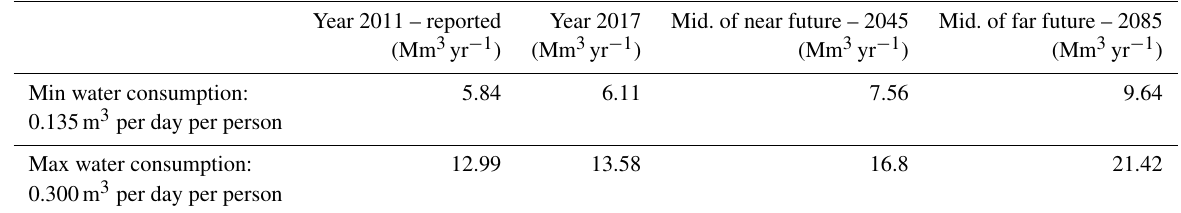
Table 4. Minimum and maximum estimated demand for consumptive water use according to the data reported for the water required and population growth currently and in the